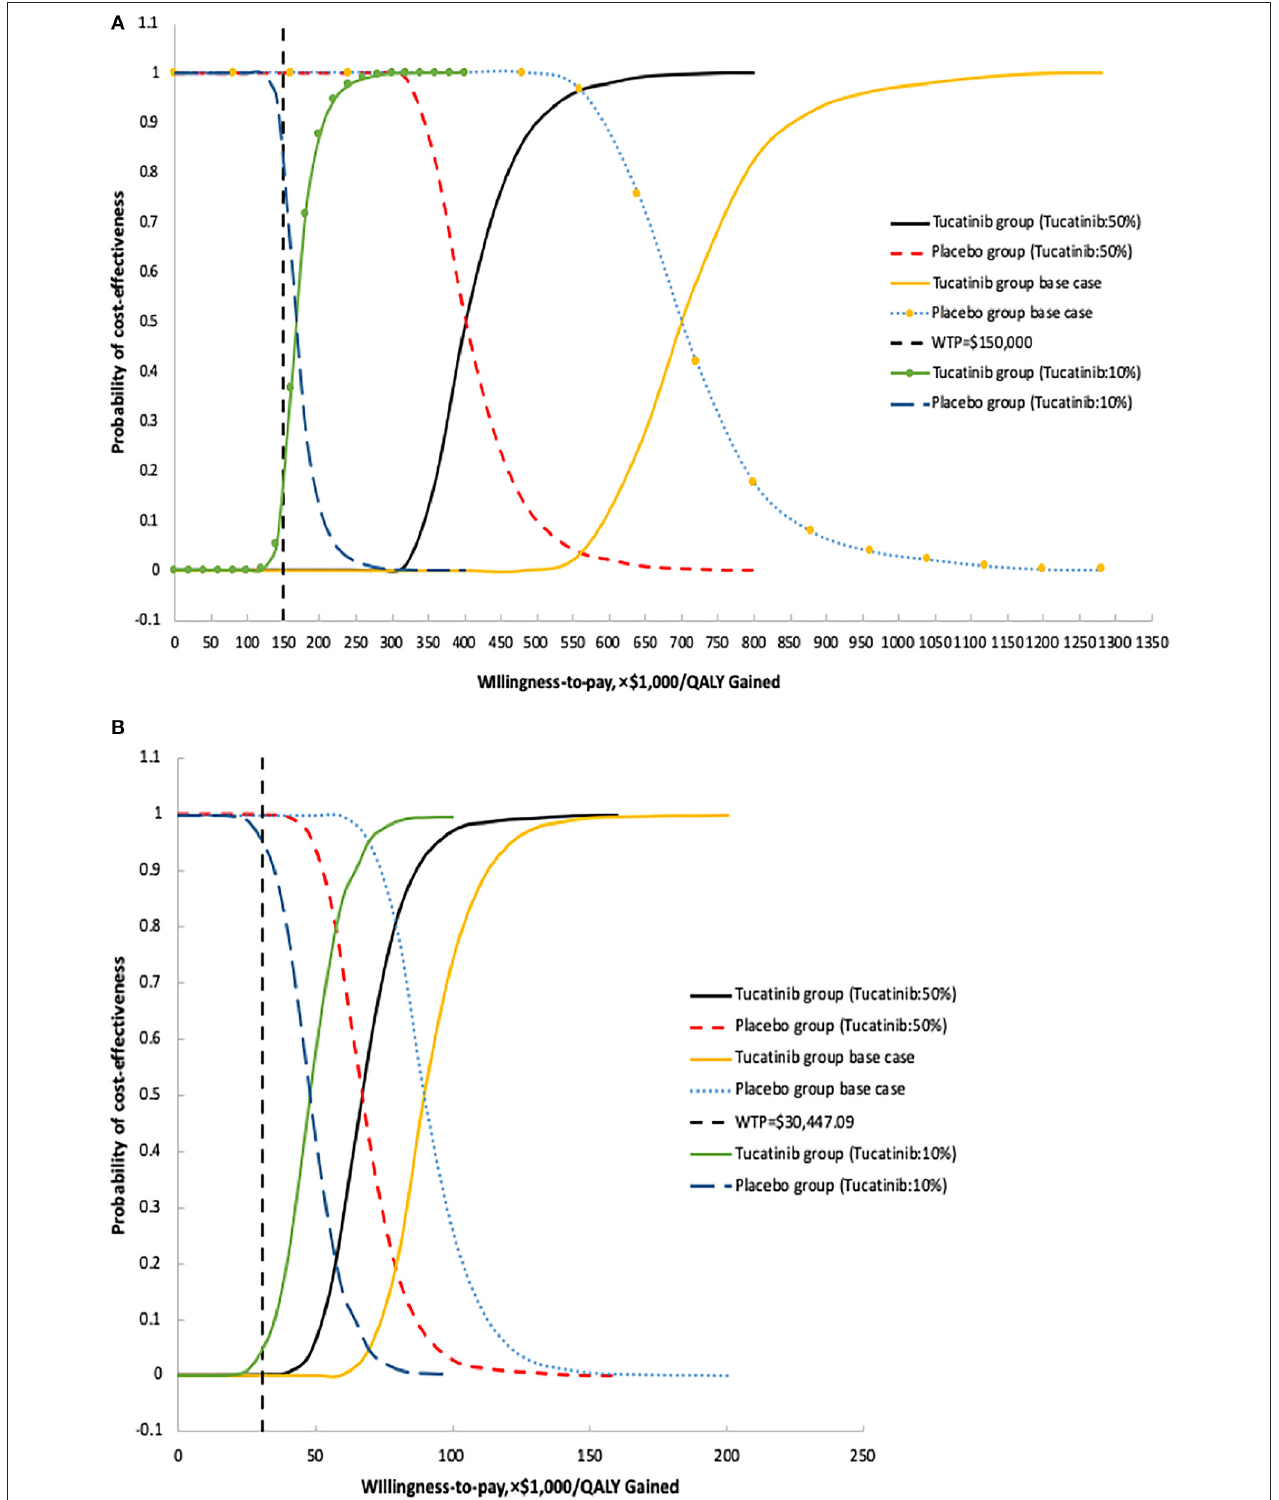
FIGURE 4 | Probabilistic sensitivity analysis for cost effectiveness of treatment strategies for HER2 positive metastatic breast cancer. Cost-effectiveness acceptable curves are showing the cost-effective probability of tucatinib, trastuzumab, and capecitabine at different prices from the United States (A) and Chinese (B) perspectives. The dotted vertical lines represent the willingness to pay thresholds.